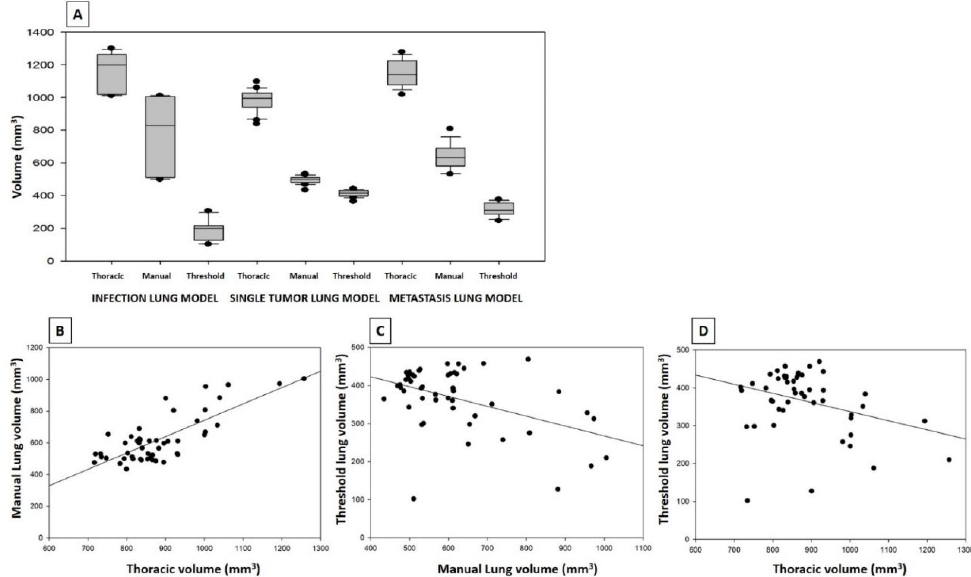
Figure 5. Thoracic, manually delineated and thresholded lung volumes of pathologic groups. ( A ) Mean values of volumes from the three calculations in metastatic model, transgenic lung tumor model and fungal infection model) ( B ) Correlation between thoracic and manually delineated lung volumes including the data from the different animal models (mm 3 ), R 2 : 0.619. ( C ) Correlation between manually delineated and thresholded lung volumes in the same batch of data (mm 3 ), R 2 : 0.242. ( D ) Correlation between thoracic and threshold lung volumes (mm 3 ), R 2 : 0.038. Note the lack of correlation between threshold volume and the other volumes, while there is a significant correlation between thoracic and manually delineated volumes, as in the healthy group. All the statistical values are displayed in Table A3.